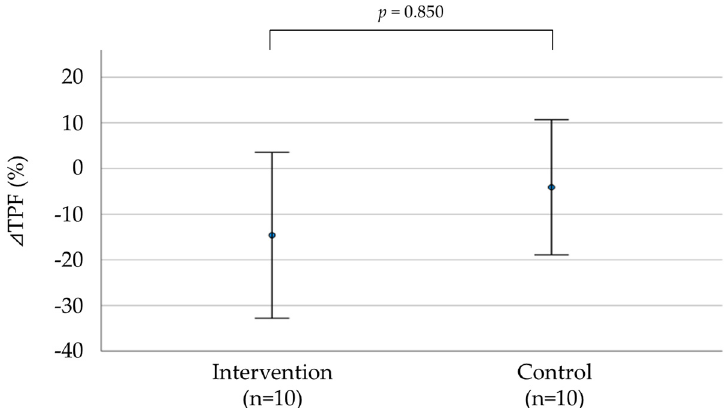
Figure 4. Comparison of the change in ⊿ TPF 6 months after completion of the exercise intervention program. ⊿ Represents the change in parameters. The Mann–Whitney U test was used for comparison between the two groups. Table 3. Comparison of the changes in clinical characteristics and continuation of exercise therapy 6 months after completion of exercise intervention program.